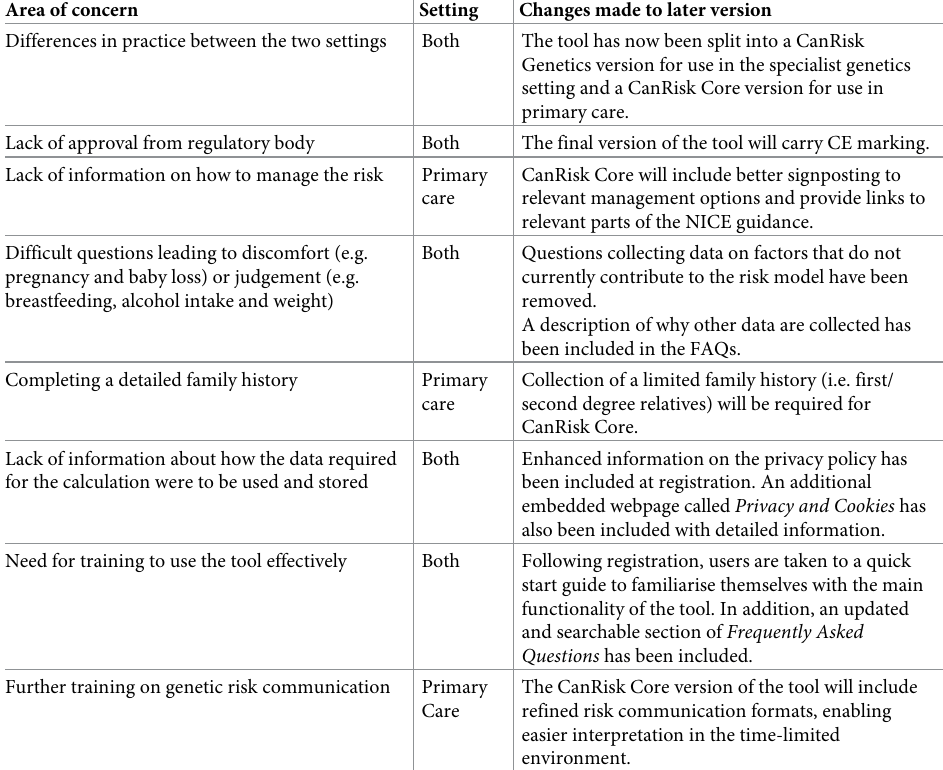
Table 4. Summary of changes made to the prototype CanRisk